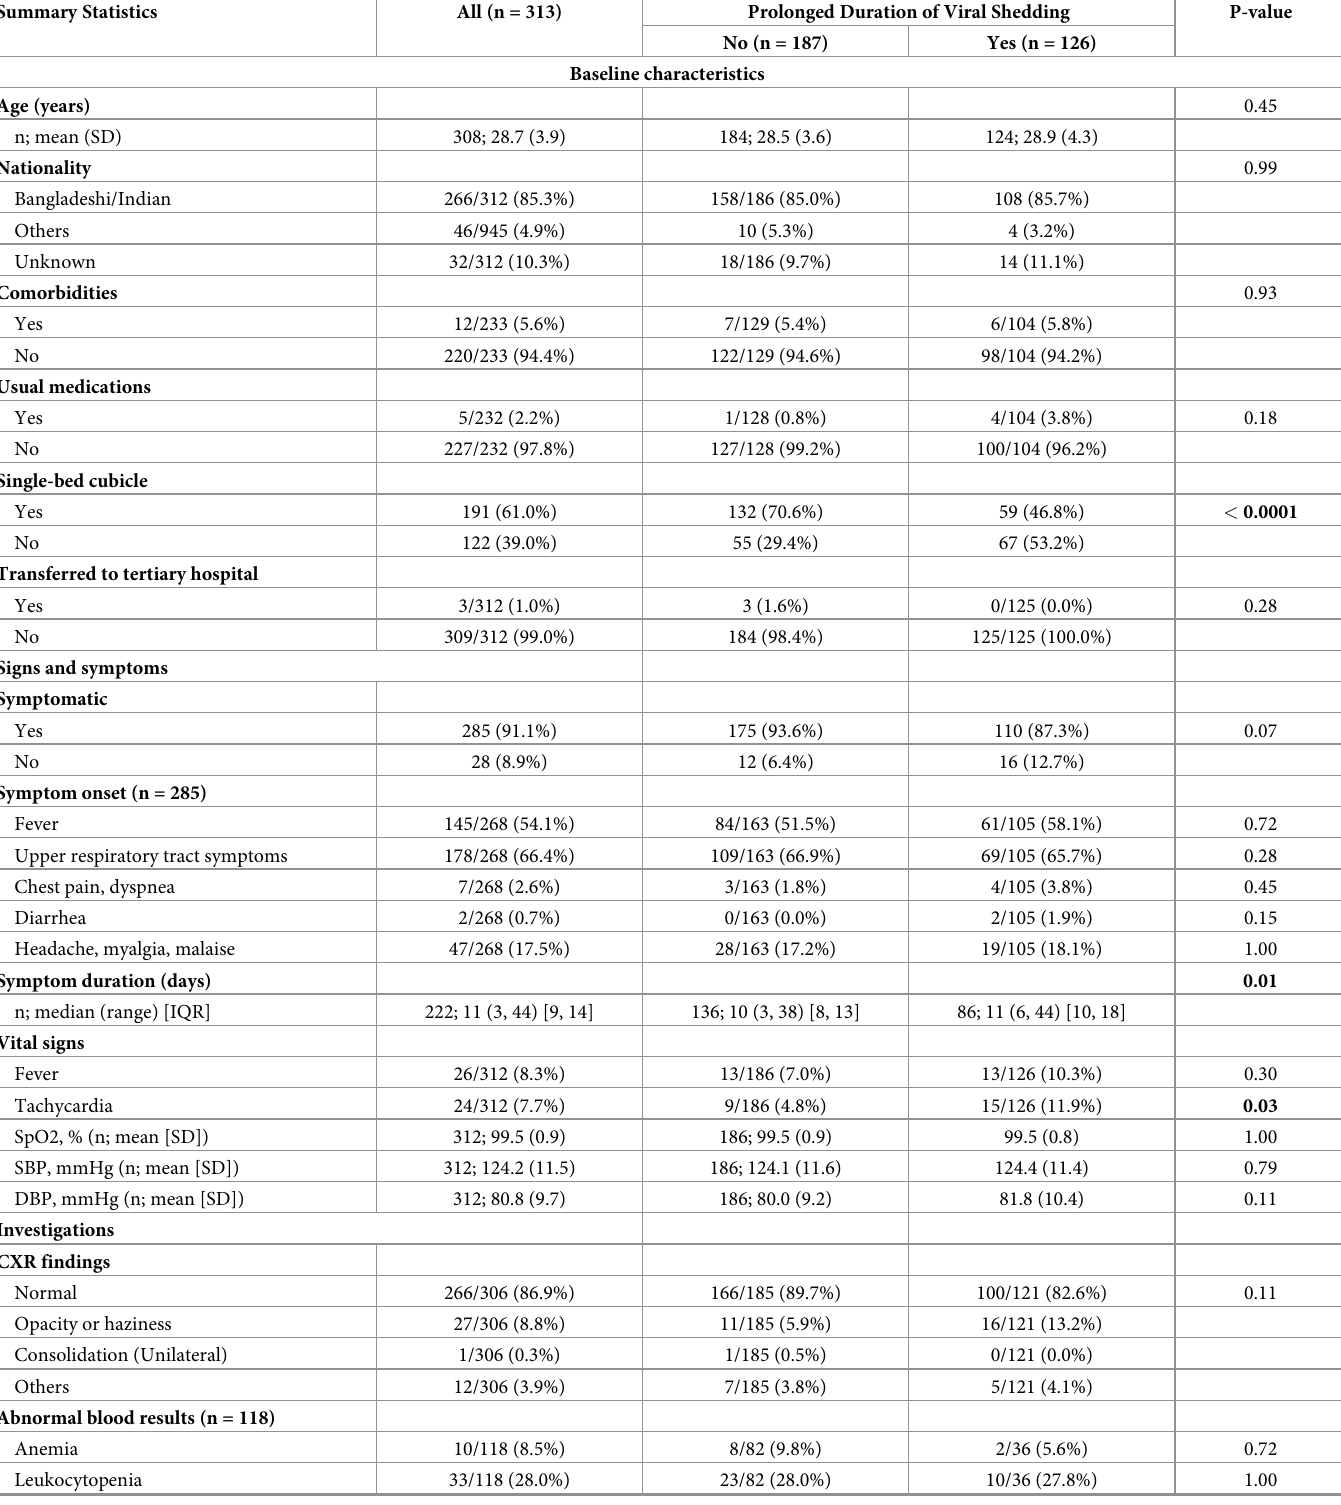
Table 2. Factors affecting duration of viral